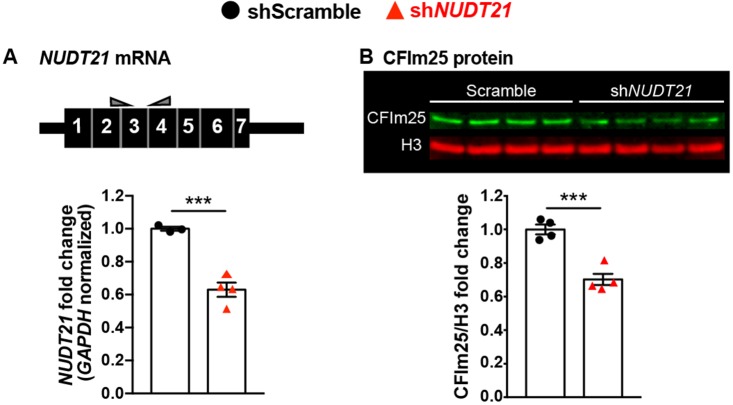
Human embryonic stem cell derived neurons infected with shRNA targeting NUDT21 have 30% less CFIm25 protein.(A) Schematic of NUDT21 mRNA with qPCR primers (top) and RT-qPCR quantification of NUDT21 mRNA levels in human embryonic stem cell (ESC)-derived neurons infected with scrambled shRNA (shScramble) or shRNA targeting NUDT21 (shNUDT21). The neurons infected with shNUDT21 have a 40% reduction of GAPDH-normalized NUDT21: p=0.0009, n = 3–4/treatment. (B) Western blot image and quantification showing a 30% reduction of H3-normalized CFIm25 protein in shNUDT21-infected neurons: p=0.0005, n = 4/treatment. We confirmed that CFIm25 does not regulate H3. ***p<0.001.